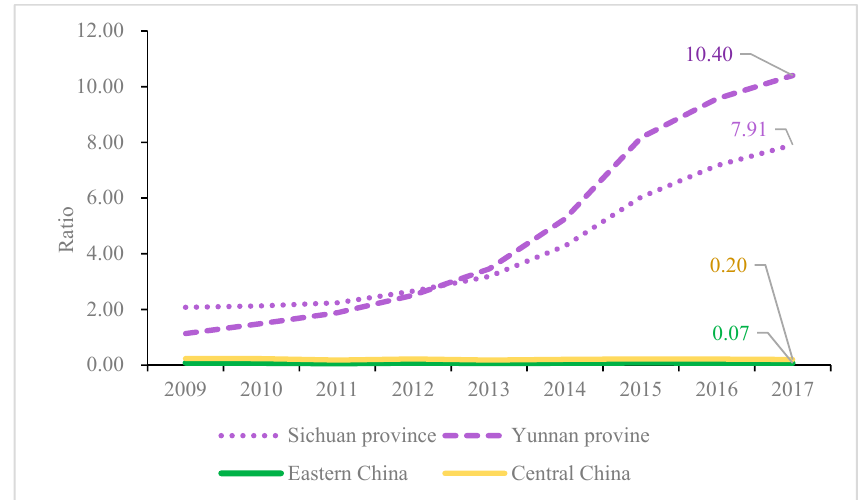
Figure 7. Proportion of electricity generated by hydropower/thermal power from 2009 to 2017 in Eastern China, Central China, and in two western provinces.